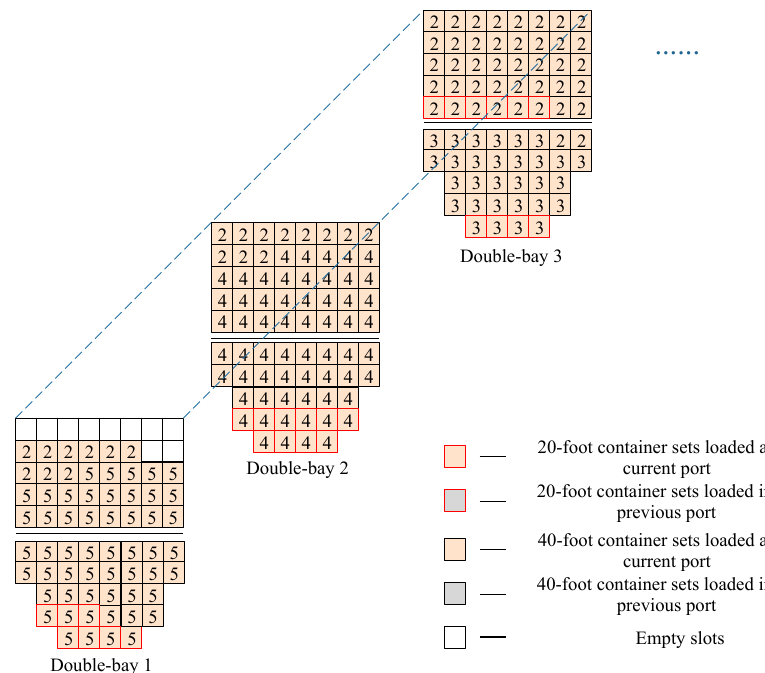
Figure 7. Stowage results in port 1 with rule